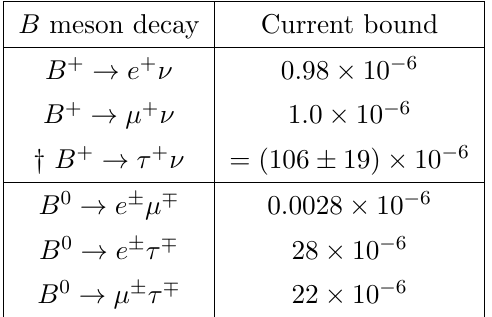
Table 3 . cLFV meson decay processes relevant in constraining the LNV modes [41].